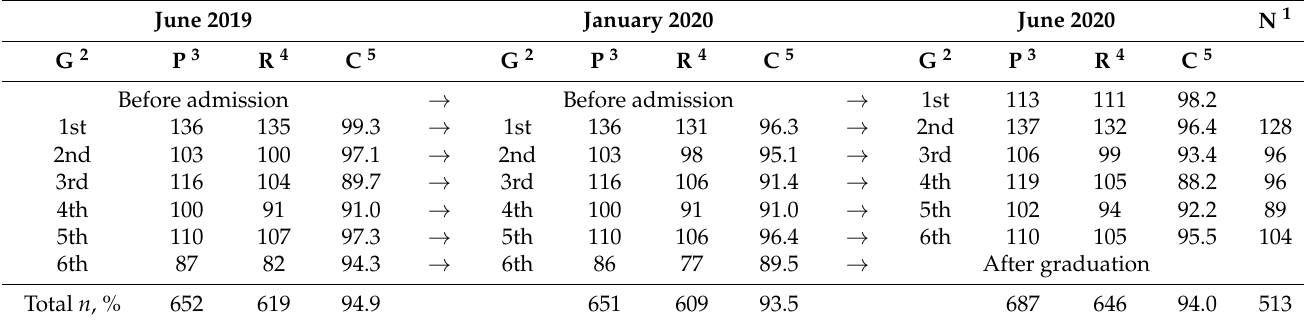
Table 1. Number of pupils and respondents at each survey